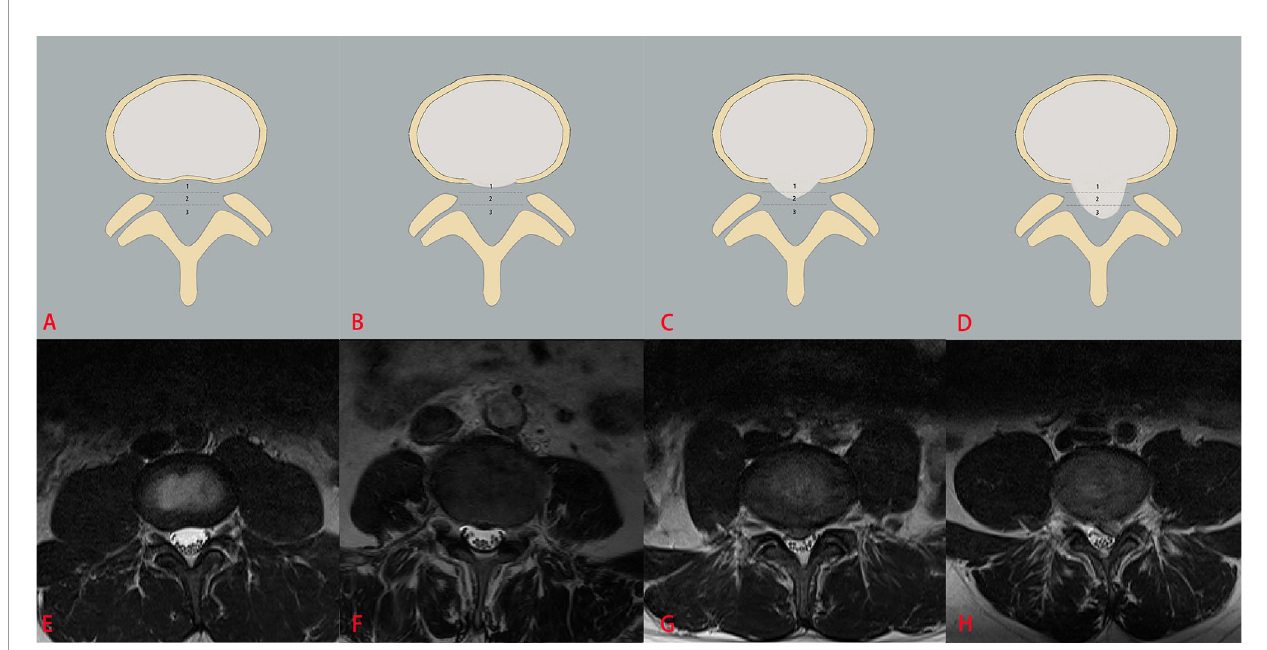
FIGURE 2 | The classi fi cation system of the lumbar disc herniation (LDH). The top column is a schematic diagram offour grades with LDH, and the bottom column is the corresponding axial T2W TSE images offour grades with LDH. The size of disc herniation is measured with reference to a single intra-facet line drawn transversely across the lumbar canal, to and from the medial edges of the right and left facet joint articulations. Grade 0 (A, E) no disc herniation; Grade 1 (B, F) the disc herniation extends up to or less than 50% of the distance from the non-herniated posterior aspect of the disc to the intra-facet line (size-1), Grade 2 (C, G) the disc herniation extends up to or more than 50% of the distance from the non-herniated posterior aspect of the disc to the intra-facet line (size-2), Grade 3 (D, H) , the herniation extends altogether beyond the intra-facet line